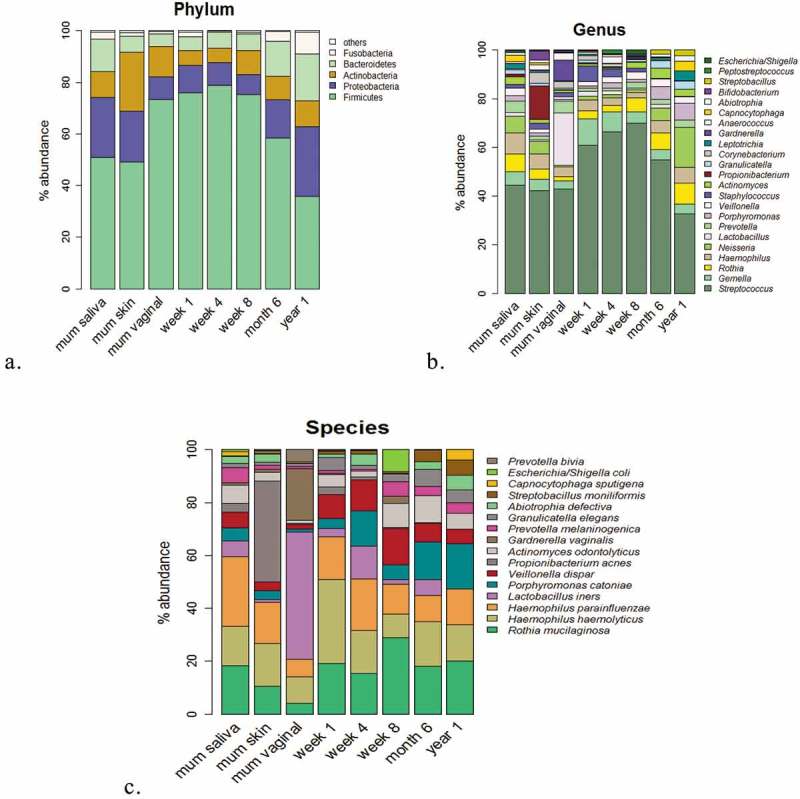
Broad and fine detail compositional differences at genus, phylum and species level.(a) Microbiota composition at phylum level. Percentages for each taxon represent the median abundance values for the sample types. (b) Bar plot of percentage abundance at the genus level. Percentages for each taxon represent the median values for the groups. (c) Bar plot of percentage abundance at species level. Percentages for each taxon represent the median values for the groups.